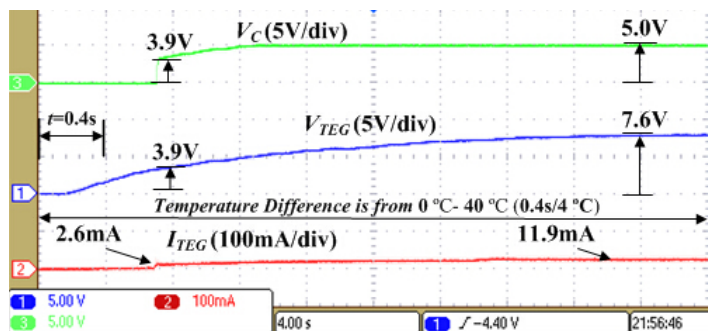
Figure 13. Measured waveform of the output voltage (Channel 1) of the TE board with graphene attached as the thermally conductive material.